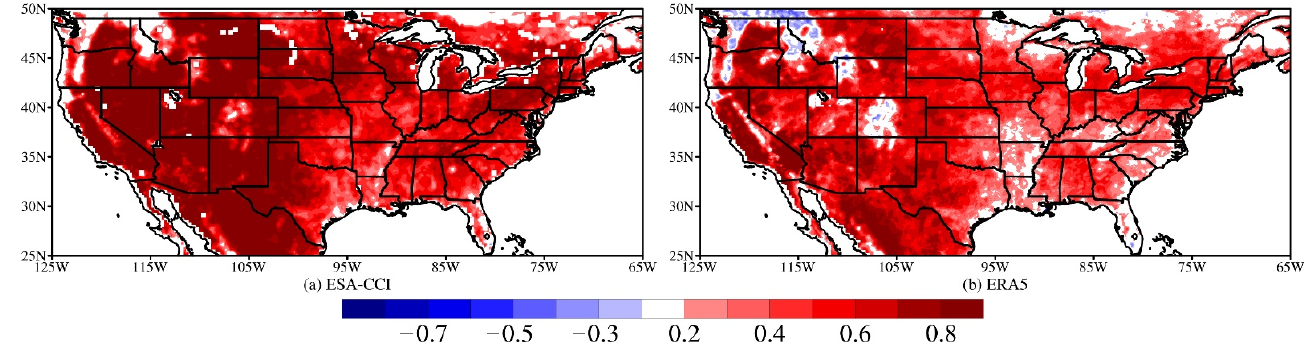
Figure 8. Spatial distribution of the correlation coefficient between the retrieved soil moisture from restored 6 GHz data and ESA ( a ) and ERA5 ( b ) reanalysis data.